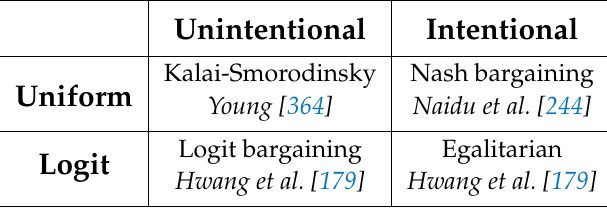
Figure 14. Conventions and bargaining solutions. Each bargaining solution can be justified as the stochastically stable state of a coordination game under the corresponding behavioral rule and without reference to any appealing ex-post properties that the solution might